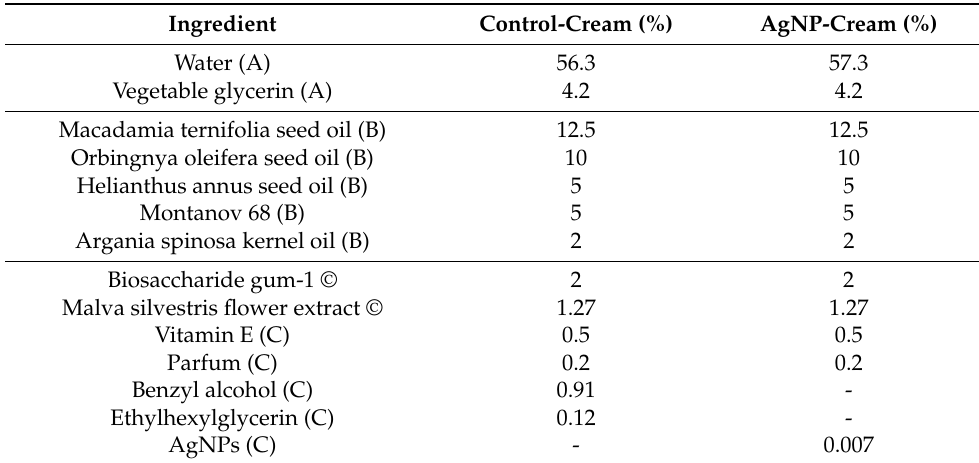
Table 3. Cream composition. A (Aqueous phase), B (Oil phase), and C (thermolabile